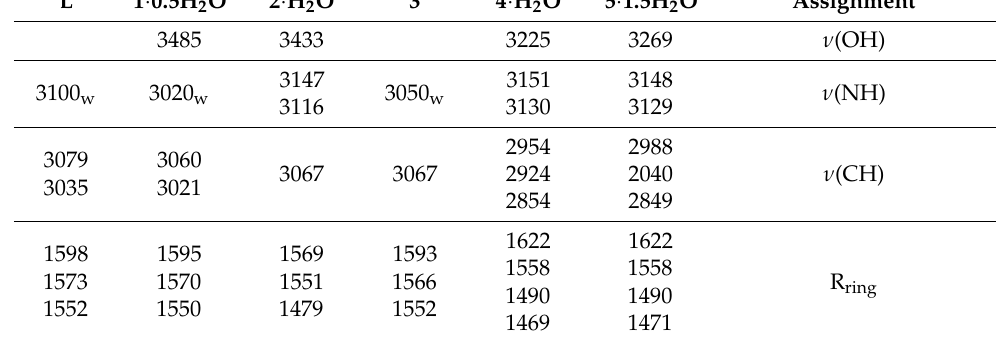
Table 3. The main vibrational frequencies (cm − 1 ) in the spectra of L and complexes.